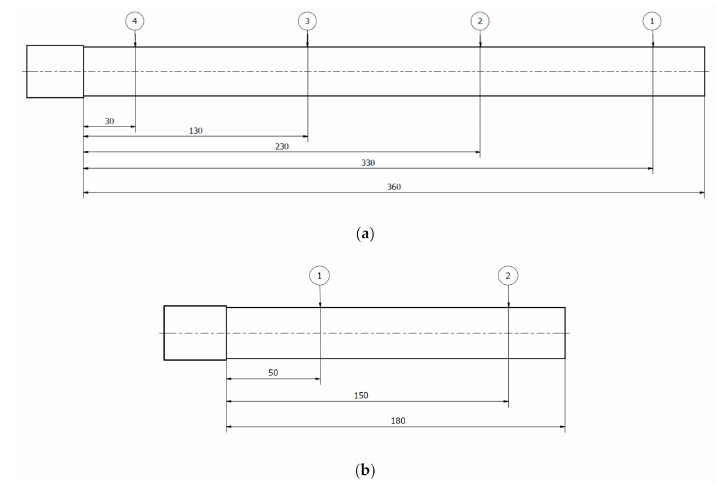
Figure 2. This the measurement positions for the shaft with L/D = 12 ( a ) and L/D = 6 ( b